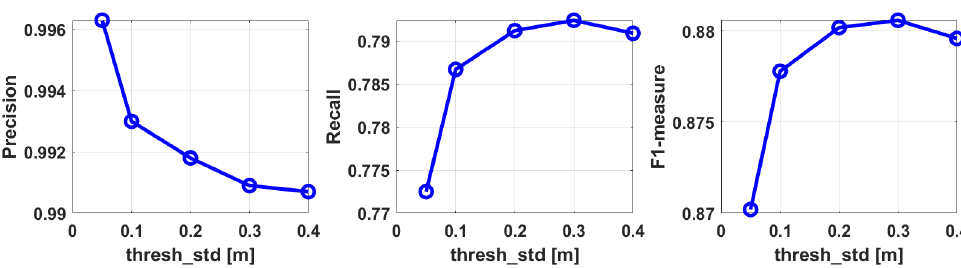
Figure 12. The standard deviation value for each grid cell in the SemanticKITTI sequence 07 dataset.